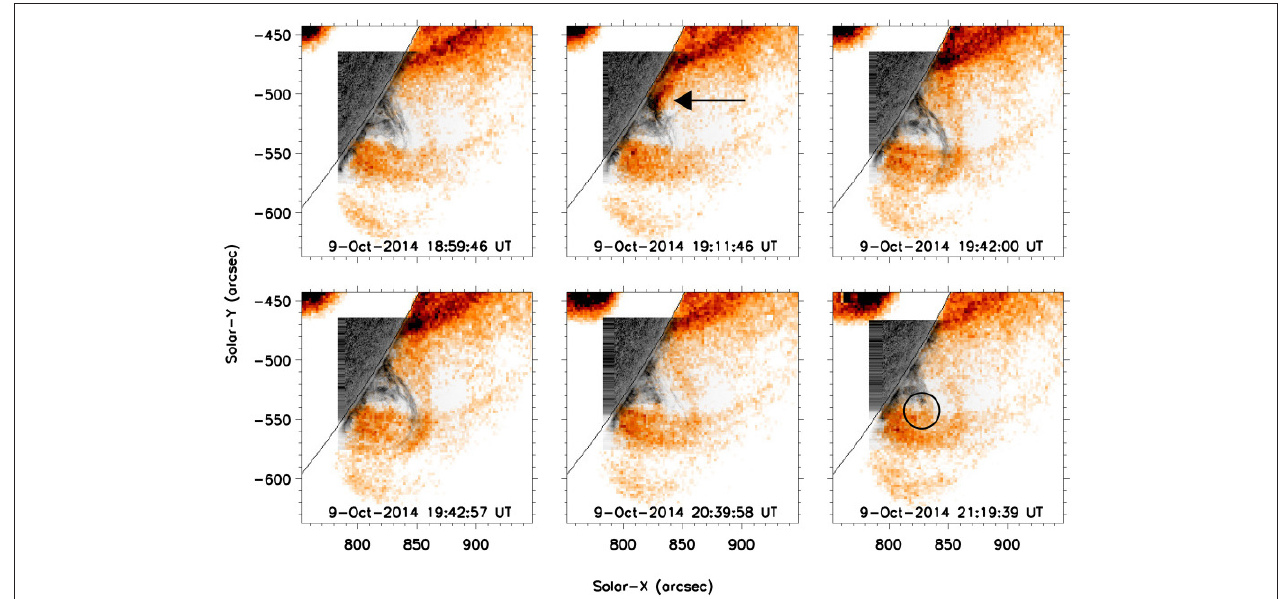
Figure 8 . These observations indicate that the eruption of